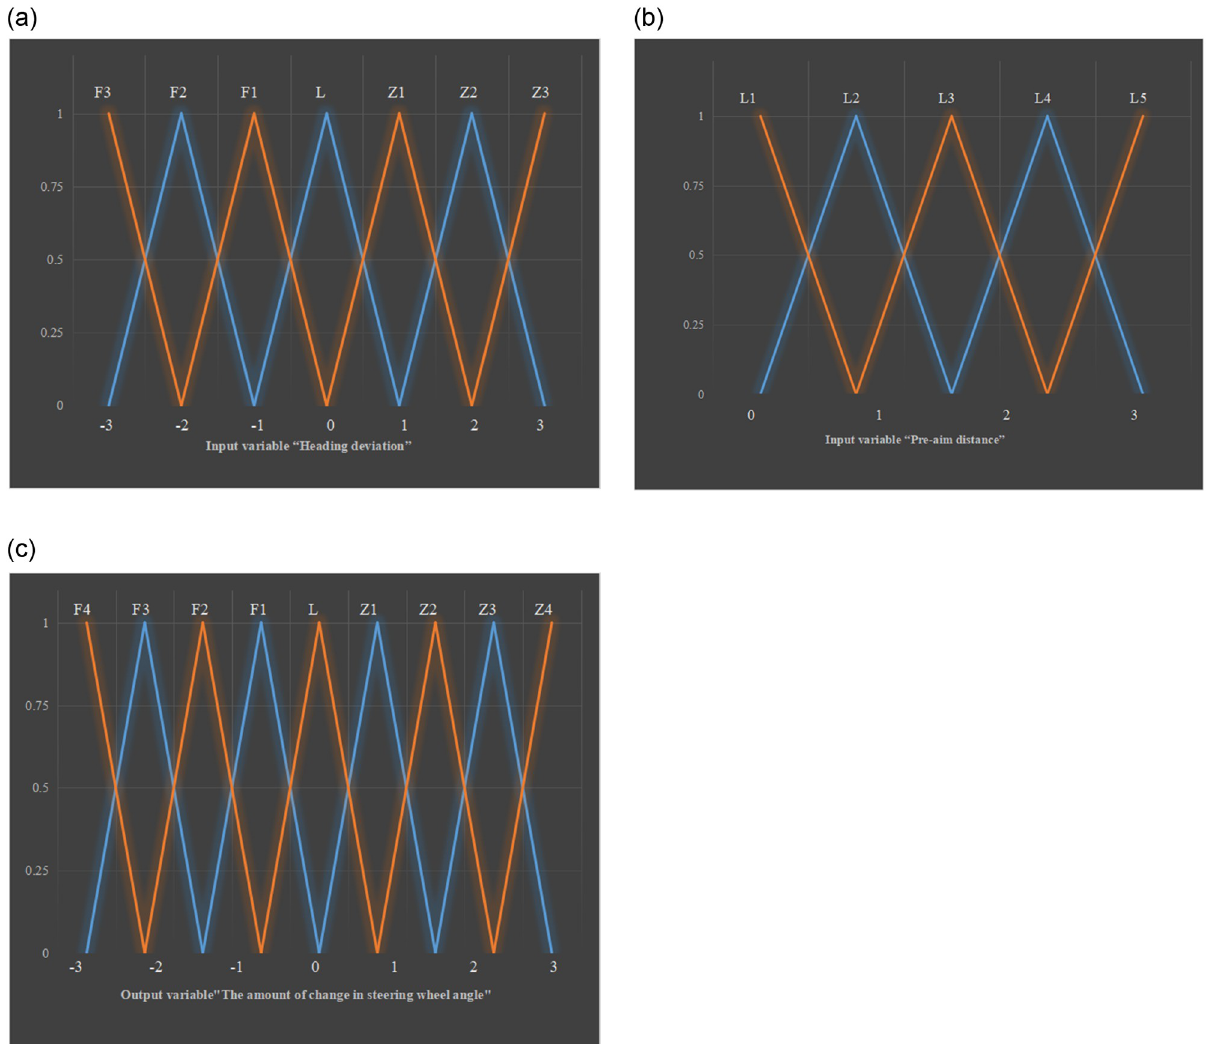
Fig 8. Membership function of input and output variables (a) heading deviation (b) preview distance (c) steering wheel angle change.